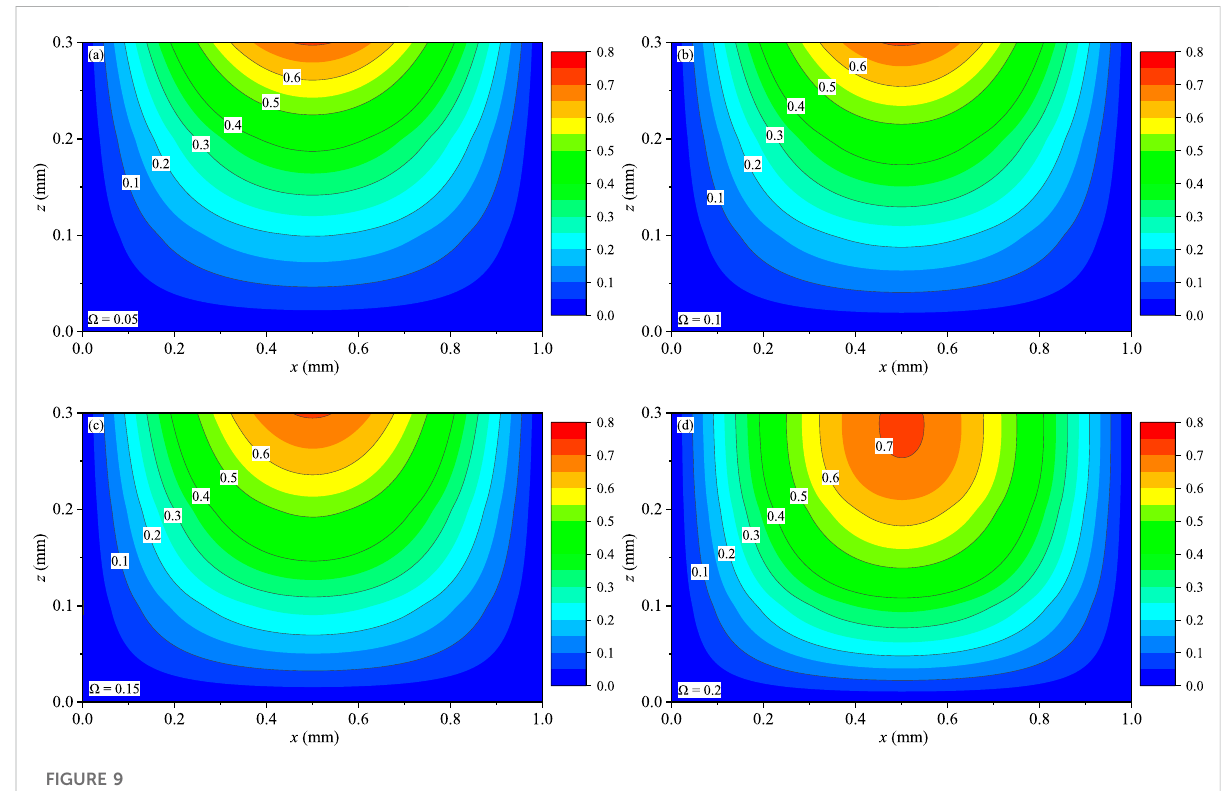
FIGURE 9 Effect of Ω on the temperature T (K): (A) Ω = 0.05, (B) Ω = 0.1, (C) Ω = 0.15, and (D) Ω =